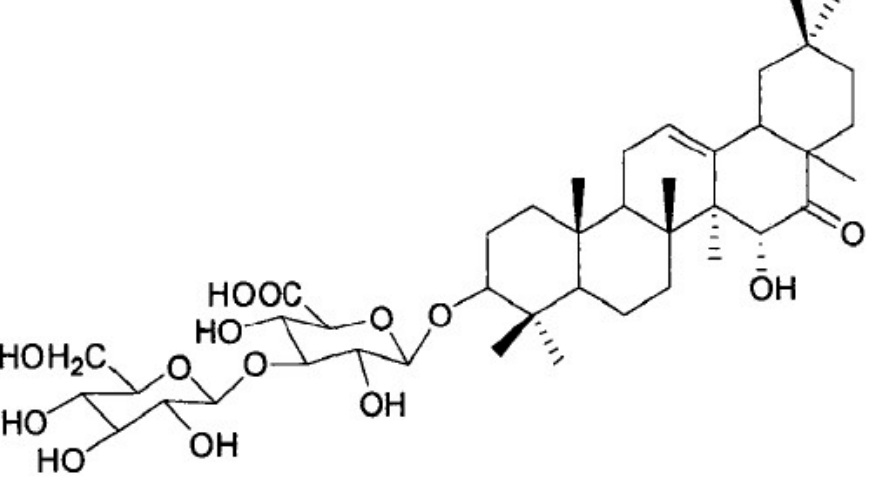
Figure 1. The chemical structure of Pedunsaponin A.